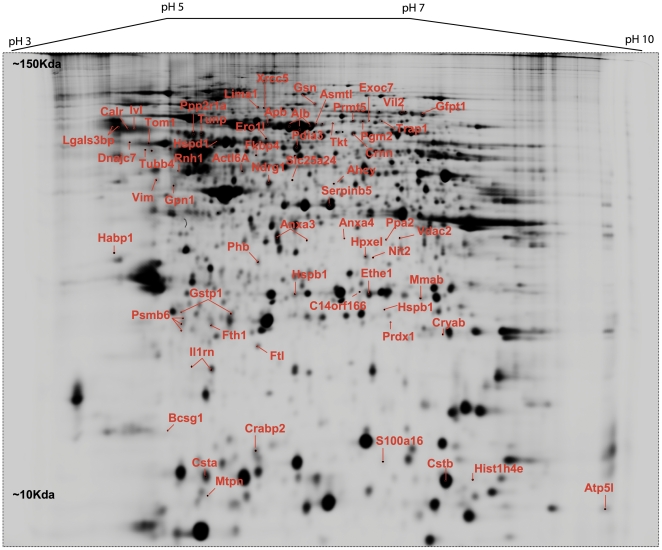
The 2D map of deep purple-labeled oral epithelial cellular proteome indicating pick location of a subset of proteins that changed in response to HIV and/or HAART.Orientation of the pH gradients is indicated on the horizontal axes from 3 pH units (left) to 10 pH unit (right), and approximate apparent molecular mass ranges are indicated along the vertical axes 10 kDa (bottom) to 200 kDa (top).